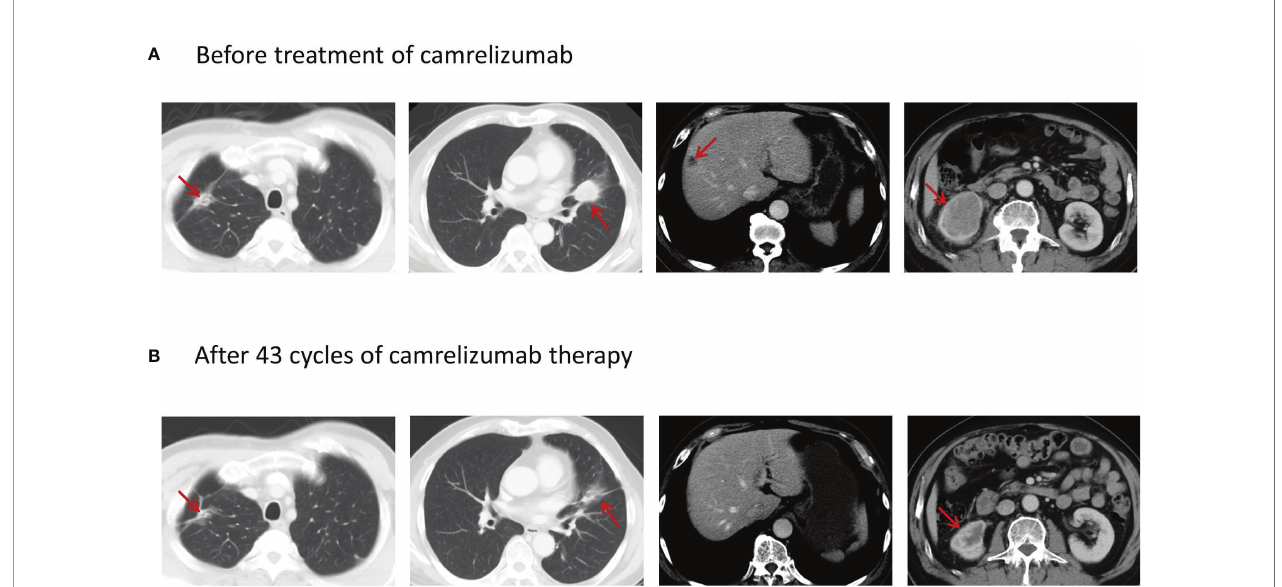
FIGURE 3 | (A) Enhanced CT scan before the treatment of camrelizumab showing a mass-like opacity in the upper lobe of the right lung with a maximum cross- sectional area of about 3.4 × 1.4 cm, a 3.3 × 2.8-cm tumor in the upper lobe of the left lung near the interlobar pleura, a low-density subcapsular nodule in the right lobe of the liver of about 1.5 × 1.4 cm in size, and a metastatic tumor in the lower right kidney with the size of about 5.9 × 4.3 cm. (B) Enhanced CT scan after 43 cycles of treatment with camrelizumab showing that the tumor in the upper lobe of the right lung was of 3.1 × 2.3 cm in maximum cross-sectional area, the tumor in the upper lobe of the left lung near the interlobar pleura decreased to the size of 1.7 × 0.8 cm, the subcapsular lesion in the right lobe of the liver was calci fi ed, and the tumor in the lower right kidney decreased to the size of 2.6 × 1.9 cm.